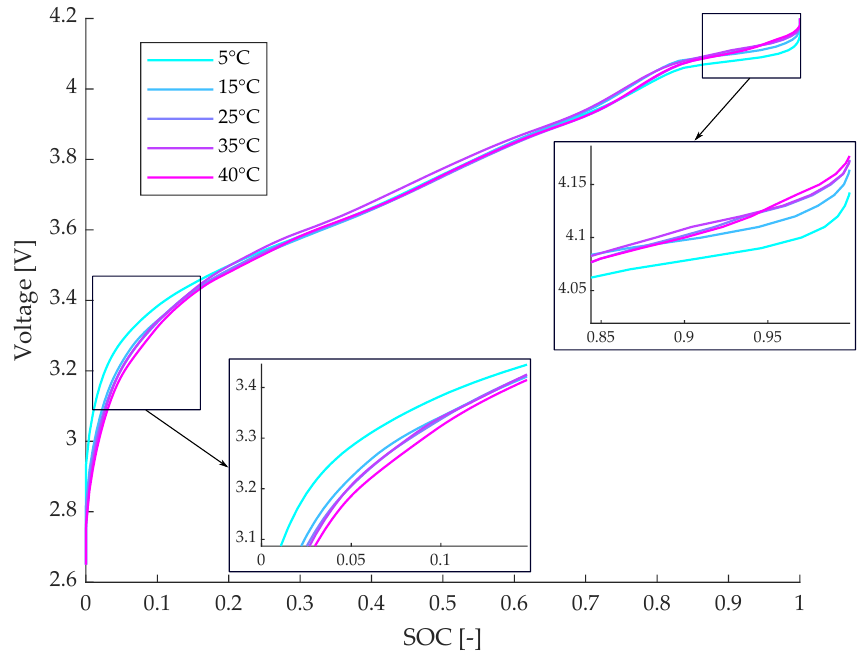
Figure 5. Open-circuit voltage (OCV)-state of charge (SOC) relationship for different